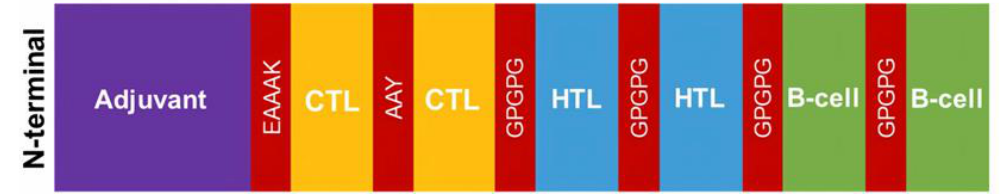
Figure 1. Epitope grouping sequence on the vaccine structure and its linkers.